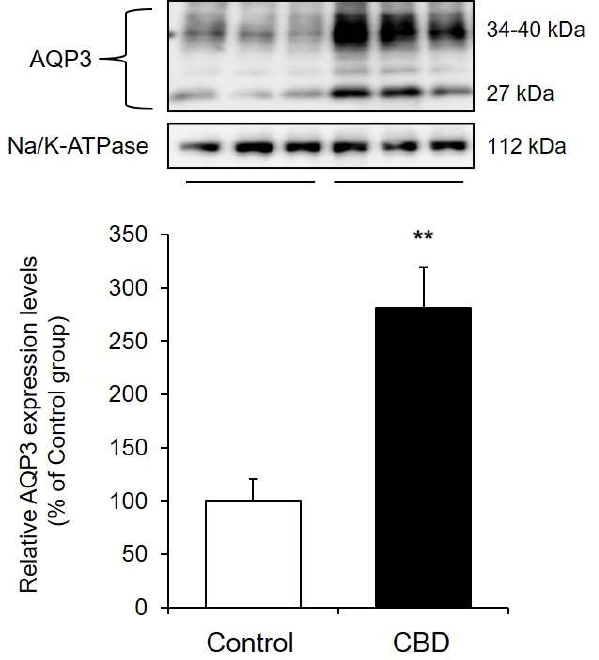
Figure 5. AQP3 protein expression levels in the skin. A 1% CBD solution was applied to the back skin of mice for 14 days. After the treatment, the protein expression level of AQP3 in the skin was analyzed by Western blotting ( n = 6, means ± SD, ** p < 0.01 vs. the control group).